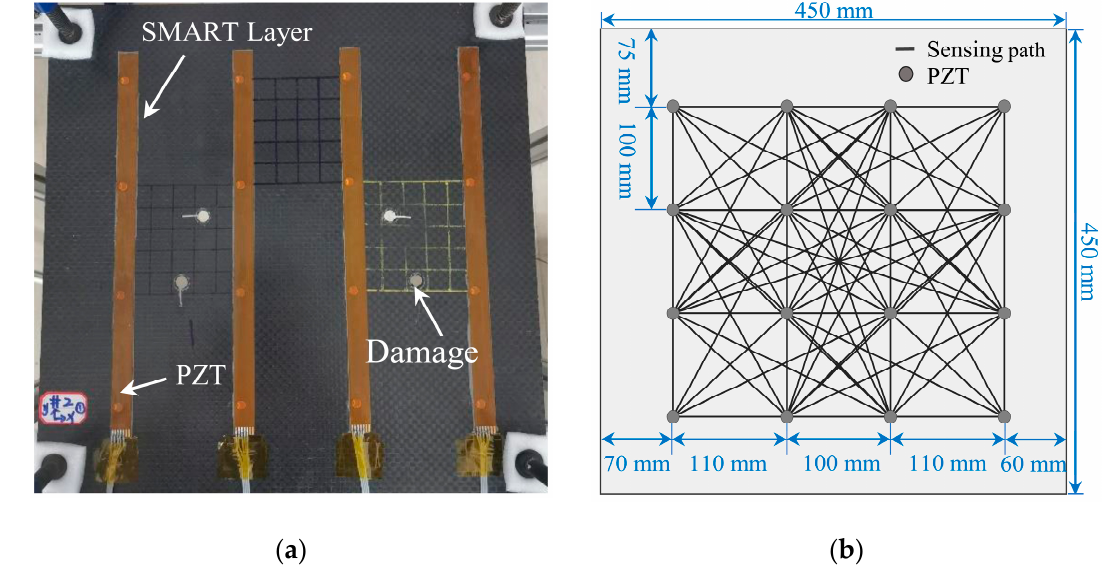
Figure 8. Experimental devices and sensor network layout. ( a ) Composite material plate-like specimen; ( b ) Preset sensor network.